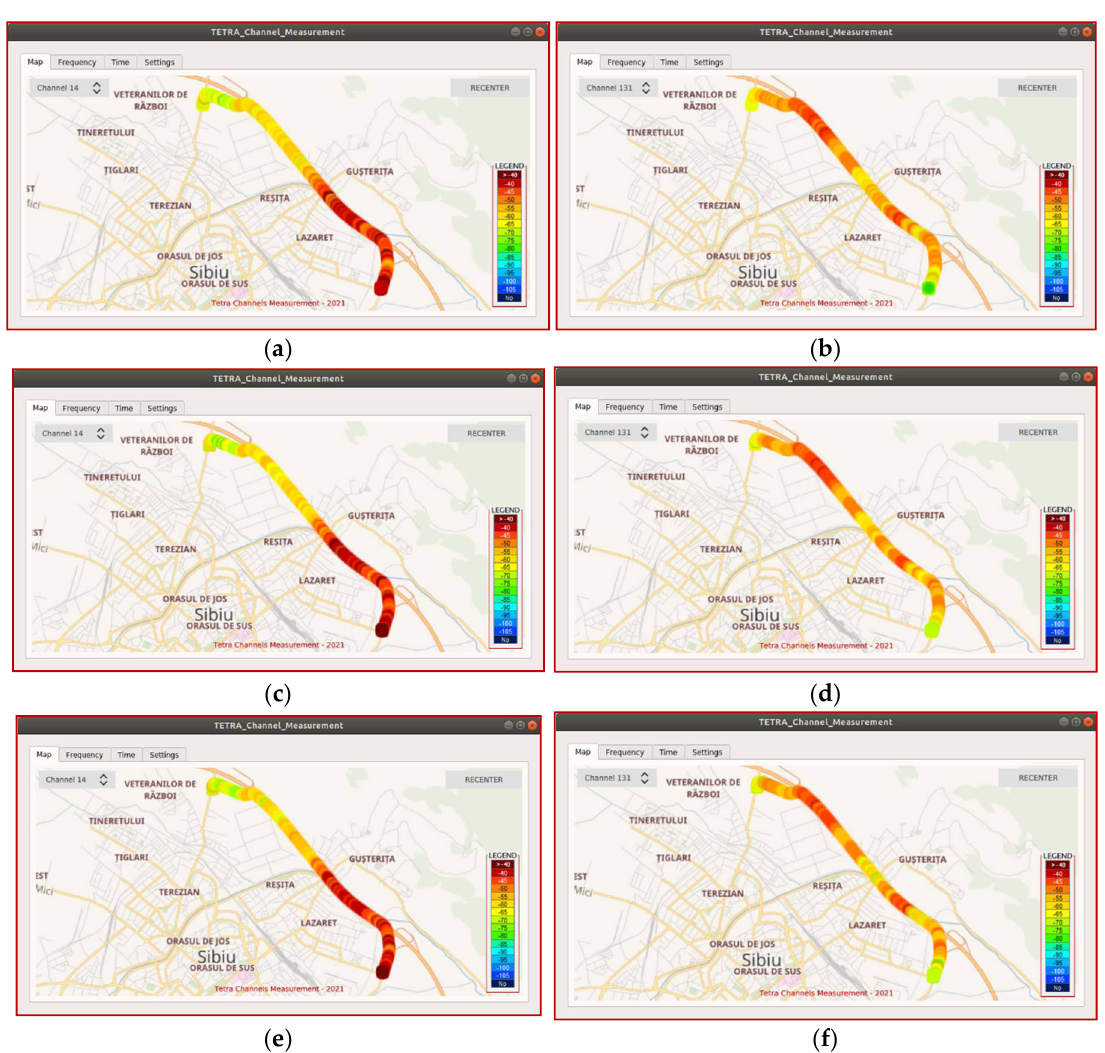
Figure 15. Representation of the measured TETRA channel powers (channel no. 14 and no. 131) when the receiving sensor was moving constantly on a route at different speeds: ( a ) channel 14, speed—60 Km/h; ( b ) channel 131, speed—60 Km/h; ( c ) channel 14, speed—90 Km/h; ( d ) channel 131, speed—90 Km/h; ( e ) channel 14, speed—120 Km/h; ( f ) channel 131, speed—120 Km/h.